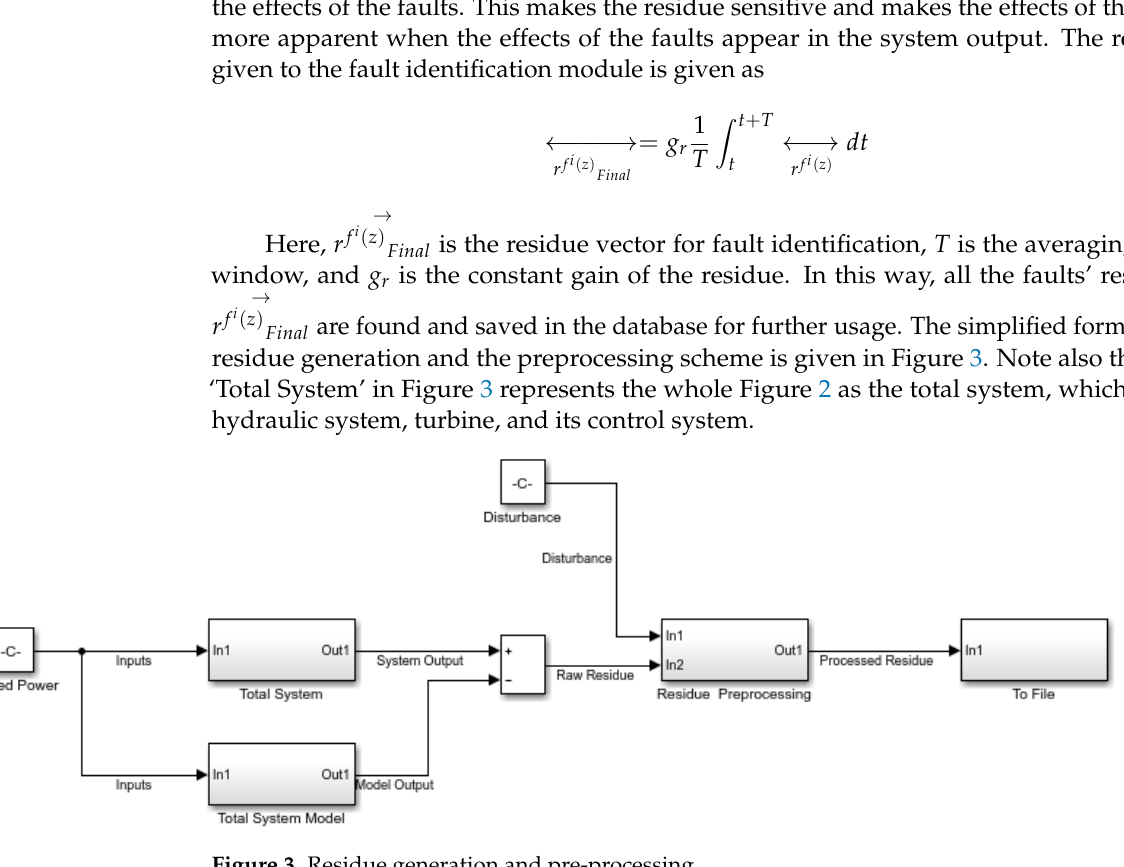
Figure 3. Residue generation and pre-processing.